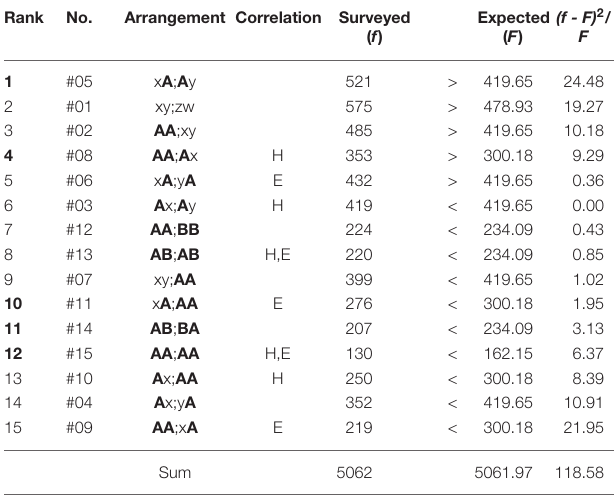
TABLE 14 | Same as Table 13 but the full names of Japanese women registered in the database of Sapporo Gakuin University. Rank No. Arrangement Correlation Surveyed